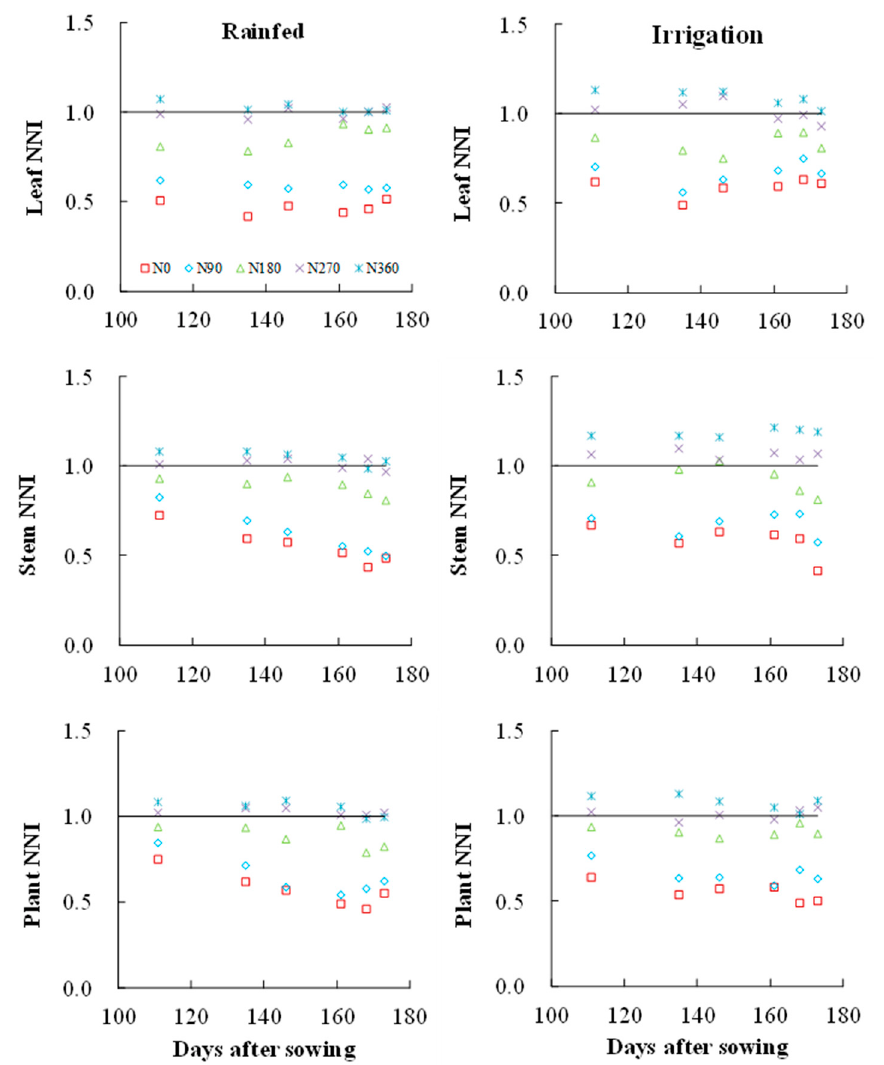
Figure 7. E ff ects of N application rates on the N nutrition index (NNI) of wheat under di ff erent Figure 7. Effects of N application rates on the N nutrition index (NNI) of wheat under different irrigation conditions in Shangshui. The datasets are from Exp. irrigation conditions in Shangshui. The datasets are from Exp. 4.